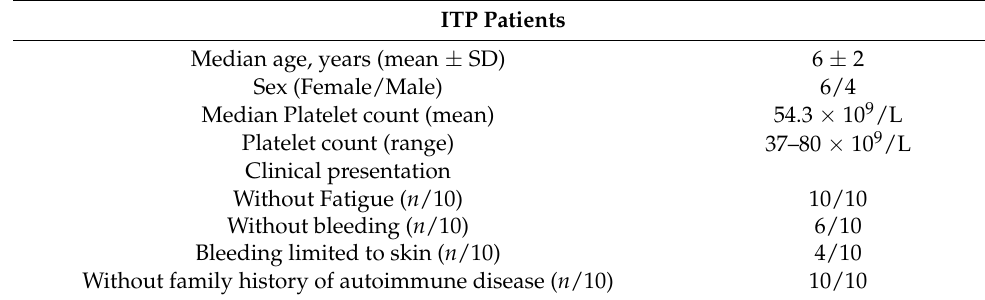
Table 1. Clinical characteristics of ITP